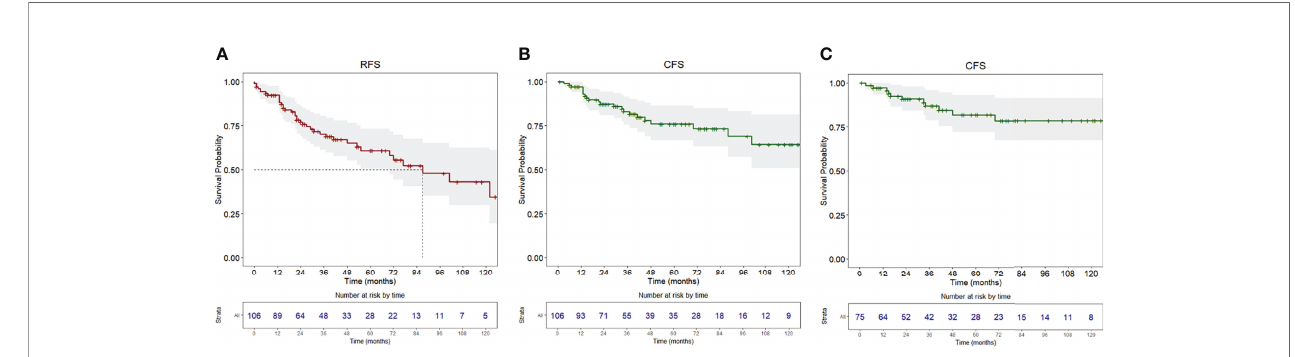
FIGURE 1 | (A) Recurrence-free survival, (B) carcinoma-free survival of the whole population, (C) carcinoma-free survival of the population without a history of previous OSCC. Survival curves are reported with relative tables of patients